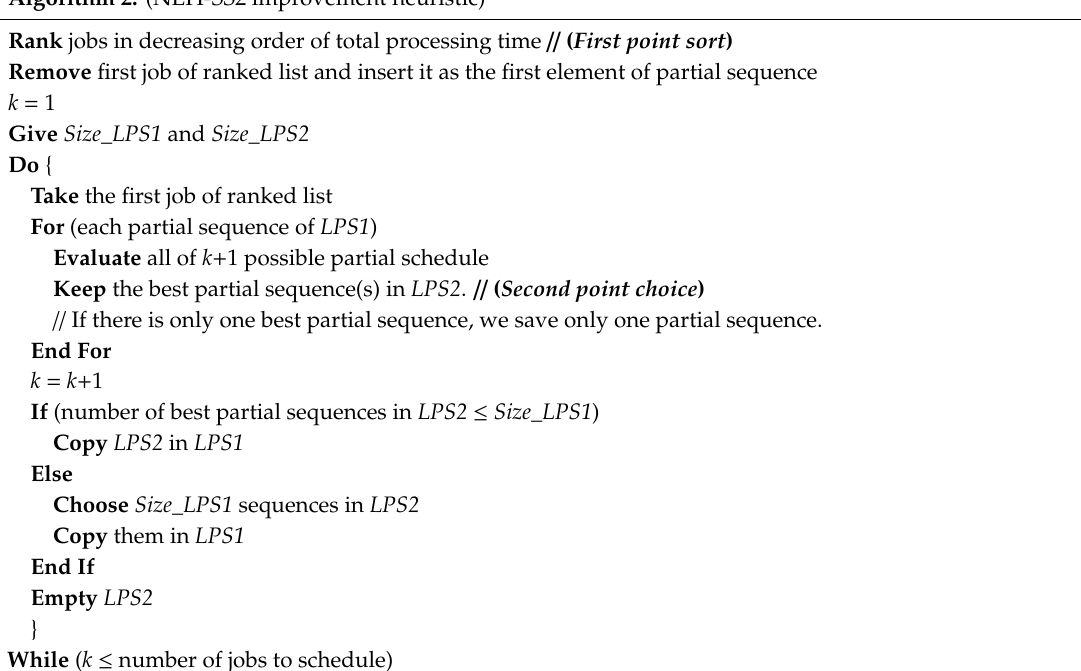
Algorithm 2: (NEH-SS2 improvement